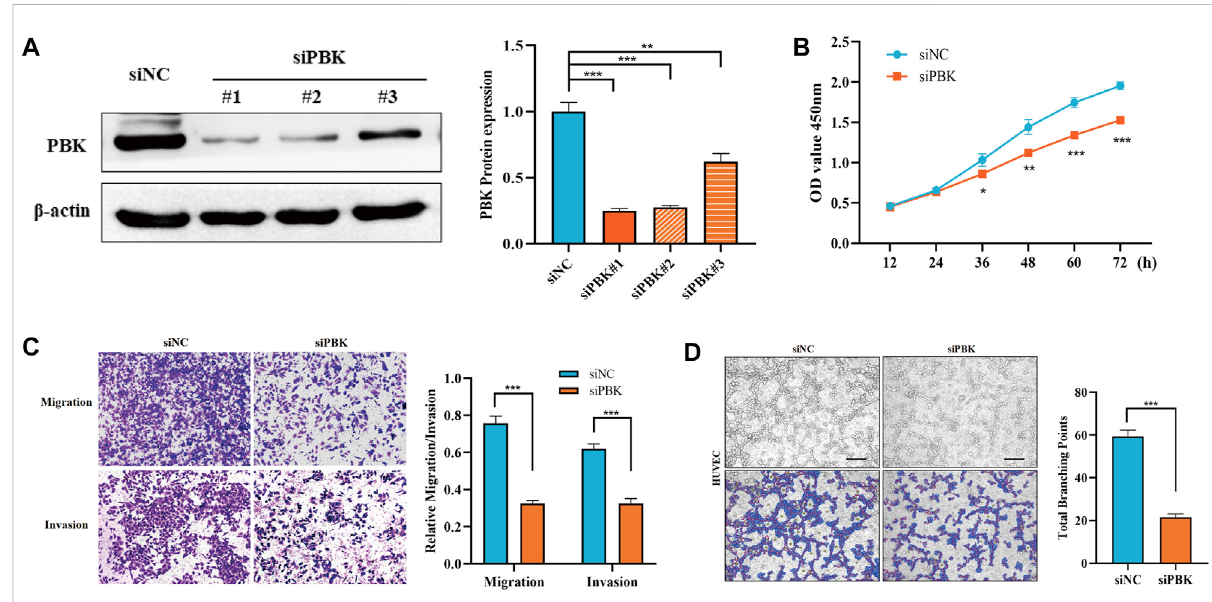
FIGURE 8 PBK promotesthemalignantprogressionofHCCcells. (A) Westernblotwasusedtodetecttheproteinexpressionof PBK inthecontroland PBK knockdowngroups. (B) CCK8assaywasusedtodetecttheproliferationabilityofHCCcells. (C) Transwellassaywasusedtodetectthemigrationand invasion abilities of HCC cells. (D) Tube formation assay was performed in HUVEC